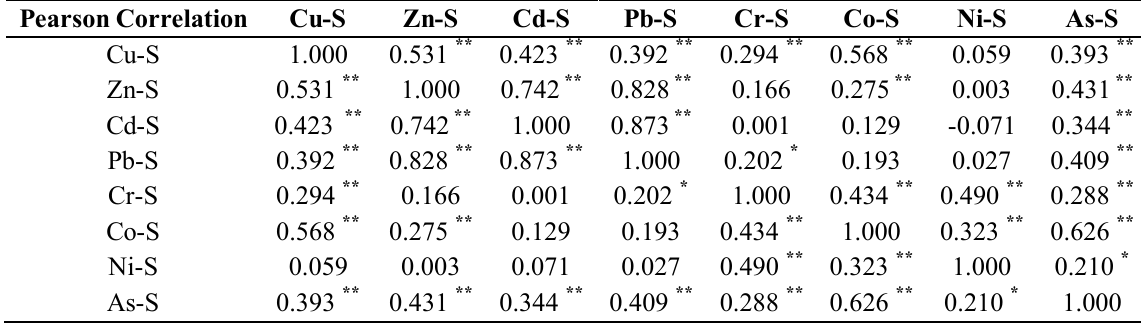
Table 8. Correlation analysis of the metal(loid) concentrations in soil.